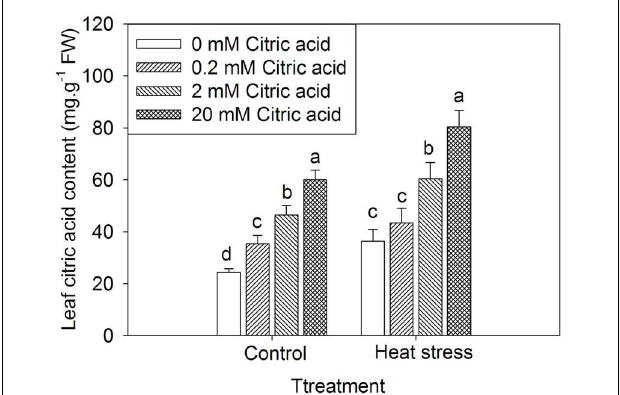
FIGURE 1 | Effect of exogenous citric acid on endogenous citric acid content under control (25/20 ± 0.5 ◦ C, day/night) and heat stressed (35/30 ± 0.5 ◦ C, day/night) conditions in tall fescue. Vertical bars on the top provide the standard deviation ( n = 4), and bars with the same letter indicate no significant difference at P < 0.05 for the comparison of different citric acid concentrations under control or heat stress.